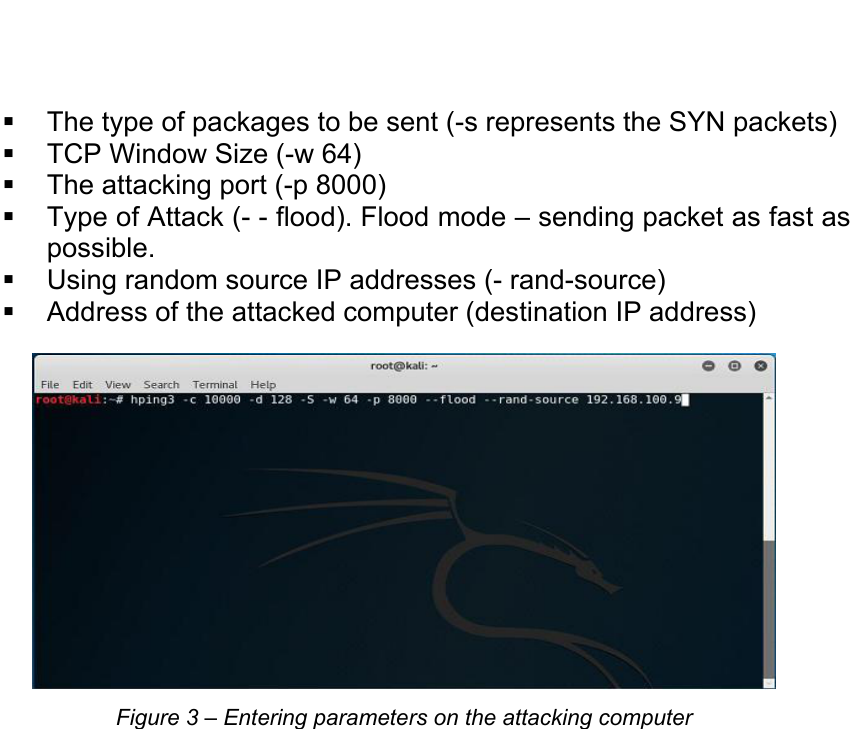
Figure 3 – Entering parameters on the attacking computer Рис . 3 – Ввод параметров в компьютер , с которого производится атака Слика 3 – Уношење параметара у рачунар којим се напада